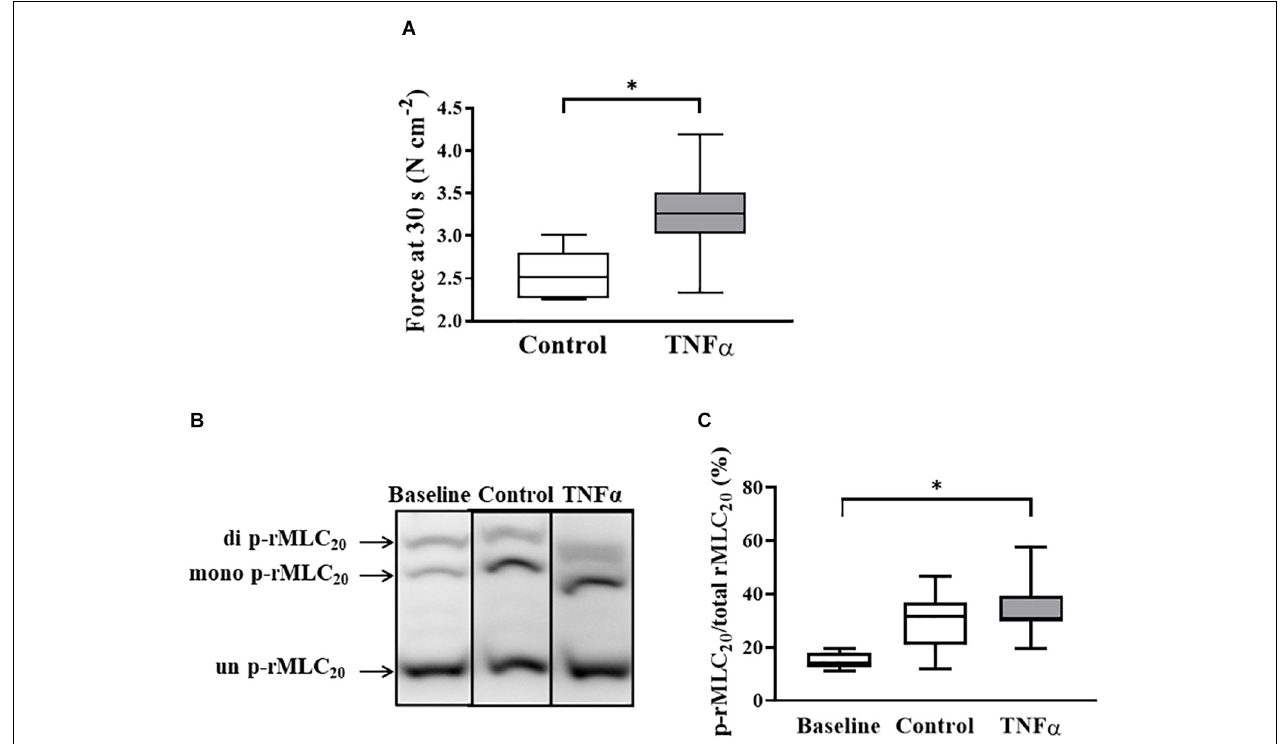
FIGURE 6 | Tumor necrosis factor α had no significant effect on rMLC 20 phosphorylation in ASM stimulated at ACh concentration (EC 50 ) [ p > 0.05, n = 6 (number of animals)] (C) , even though ACh stimulation significantly increased the extent of rMLC 20 phosphorylation in both 24-h TNF α treated and untreated control ASM strips (B,C) , compared to the baseline (no ACh stimulation). However, force generated in ASM after 30 s at ACh stimulation (EC 50 ) significantly increased with TNF α exposure, compared to controls [ ∗ p < 0.05, n = 6 (number of animals)] (A) . Representative western blots to show phosphorylated (single- and double-p-rMLC 20 ) and un-phosphorylated (un-p-rMLC 20 ) rMLC 20 using a modified Phos-tag TM gels (B) .